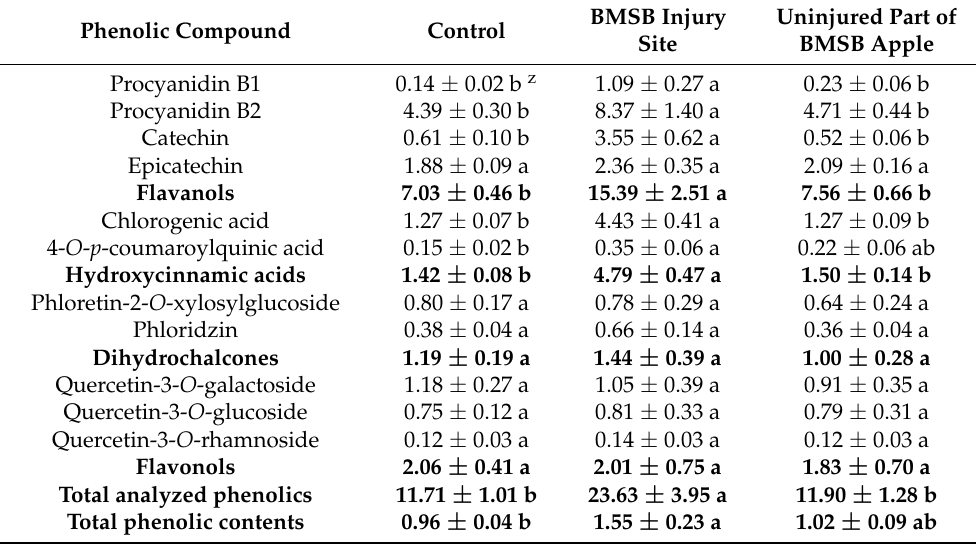
Table 3. Individual and total phenolic contents (g/kg FW, mean ± SE) in apples. Phenolic